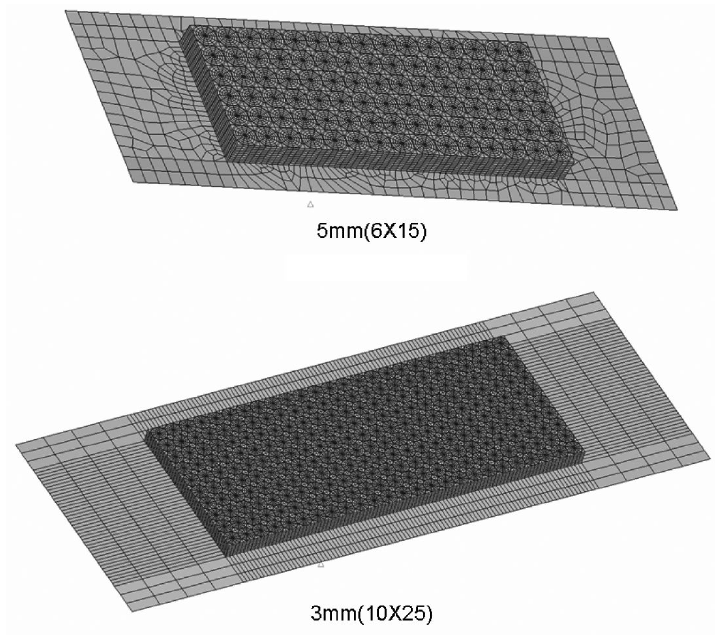
Fig. 55. Two cases of a Plate with added EIDL, up − 5 mm EIDL, bottom − 3 mm